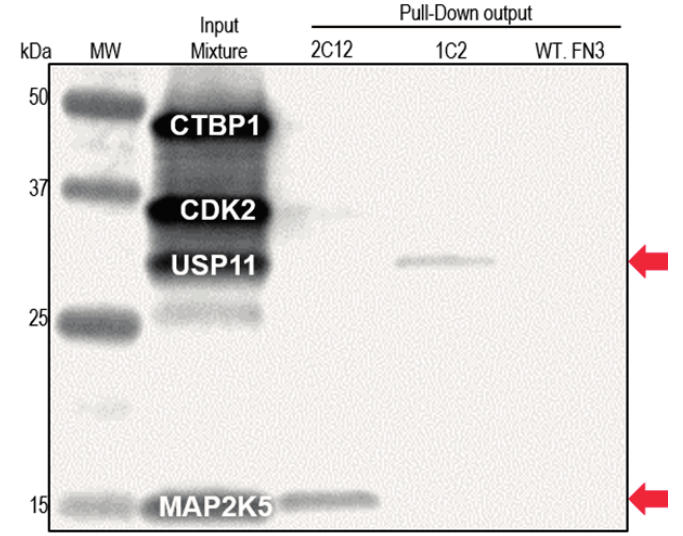
Figure 5. Pull-down of biotinylated targets from spiked HeLa cell lysate by affinity-matured monobodies. Four biotinylated targets were mixed (1 pmol each) with HeLa cell lysate (10 µg). FLAG-tagged FN3 monobodies were added to the mixture, and subsequent target/monobody complex was pulled down via anti-FLAG antibody-coated paramagnetic beads. After washing, the target/monobody complex was eluted off the beads and used in Western blot. Biotinylated targets were detected via a streptavidin-infrared dye conjugate. Red arrows indicate the positions of two pull-downed targets on the